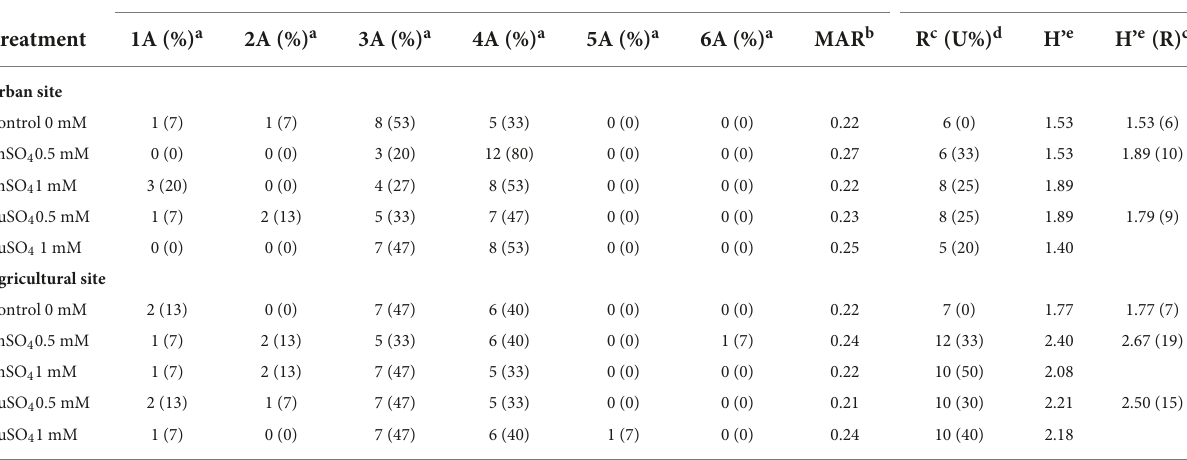
TABLE 1 Number of multi-drug resistance profiles (MDRPs) obtained from conjugation experiments in the absence and presence of ZnSO 4 and CuSO 4 at two different